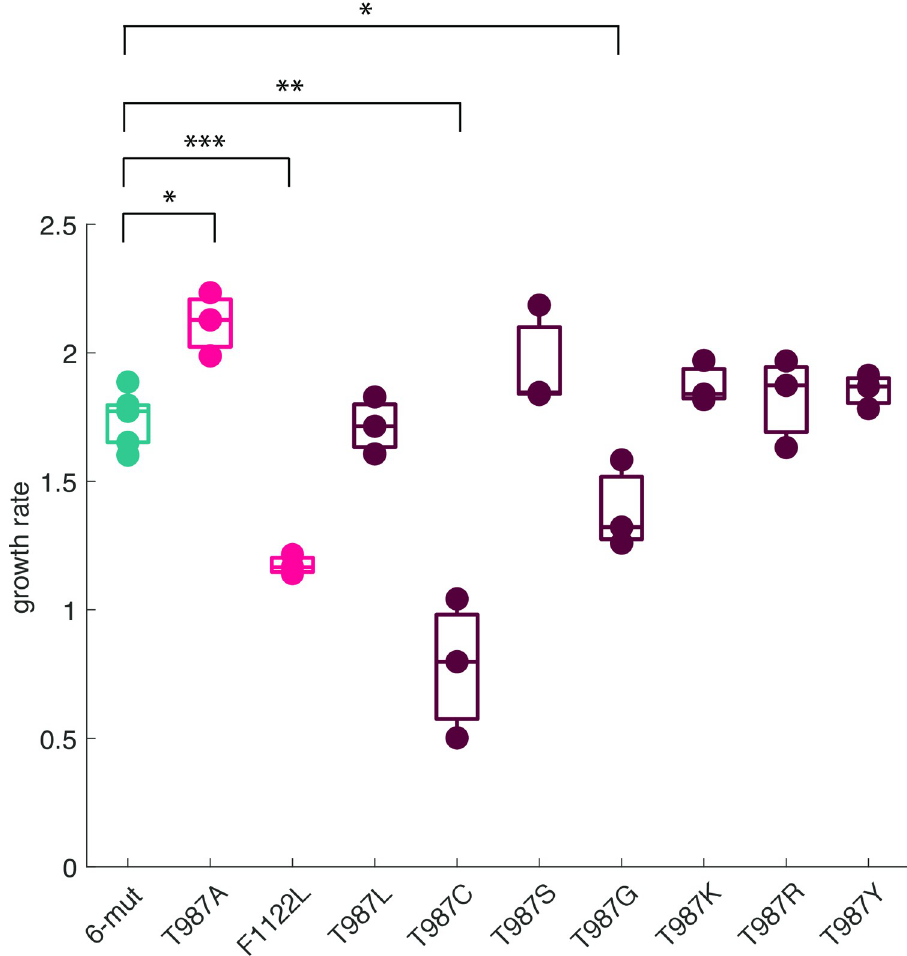
Fig 6. Growth rates of naturally occurring thermostable genotypes and engineered library genotypes. Growth rates on REL606 in M9 glucose + MgSO 4 media over four hours. Comparisons to 6-mut growth rate were made using paired t-tests corrected for multiple comparisons using the Bonferroni method, N = 3 per genotype. Significantly higher: T987A: p = 0.002; significantly lower: F1122L: p = 4.12x10 -5 ; T987G: p = 0.0052; no difference: T987L: p = 0.695; T987S: p = 0.068; T987K: p = 0.105; T987R: p = 0.419; T987Y: tstat = p = 0.150 Bonferroni adjusted significance: ns: P > 0.0056, � : P < 0.0056, �� : P < 0.00056, ��� : P < 0.000056.